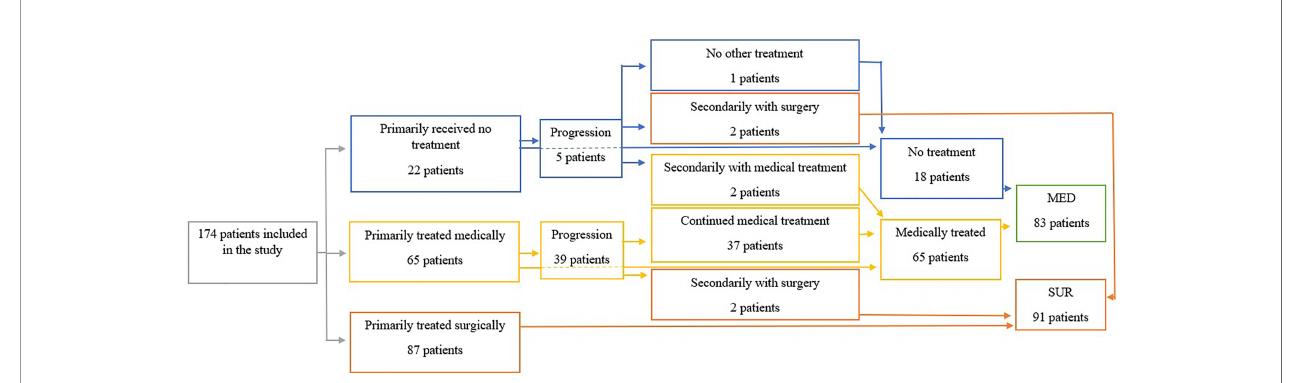
FIGURE 1 | The fl owchart of the study. MED, group of patients treated medically or with watchful wait; SUR, surgically treated